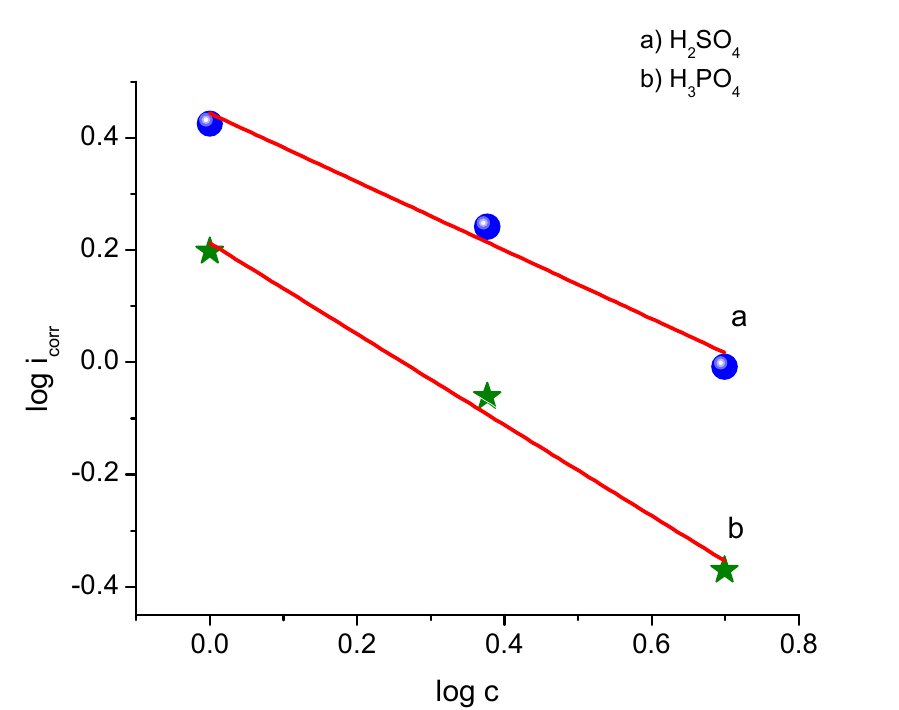
Figure 4. The variation of log i corr with log ASMS concentration at 298 °K.